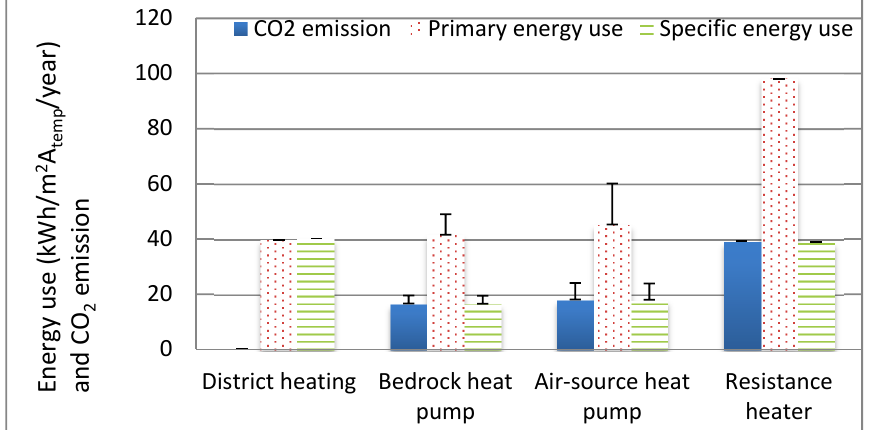
Figure 3. Average CO 2 emission, primary energy use and specific energy use of both buildings with the existing district heating system vs. assumed alternative heating